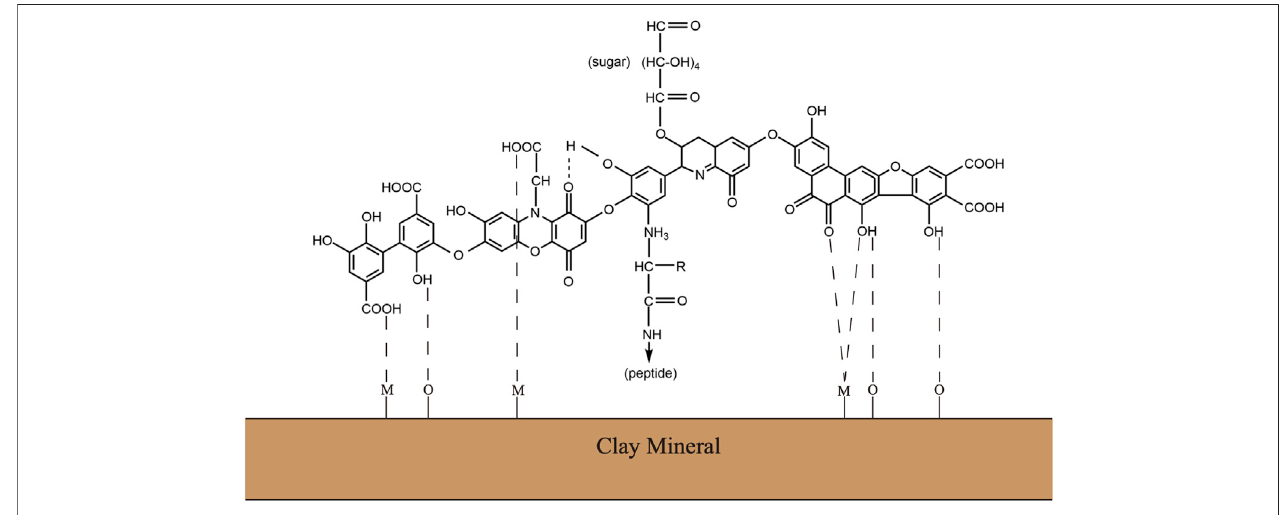
FIGURE 1 | Traditional view of the chemical complex of soil organic matters or humus substance. Modi fi ed from Wagner and Wolf (1998).